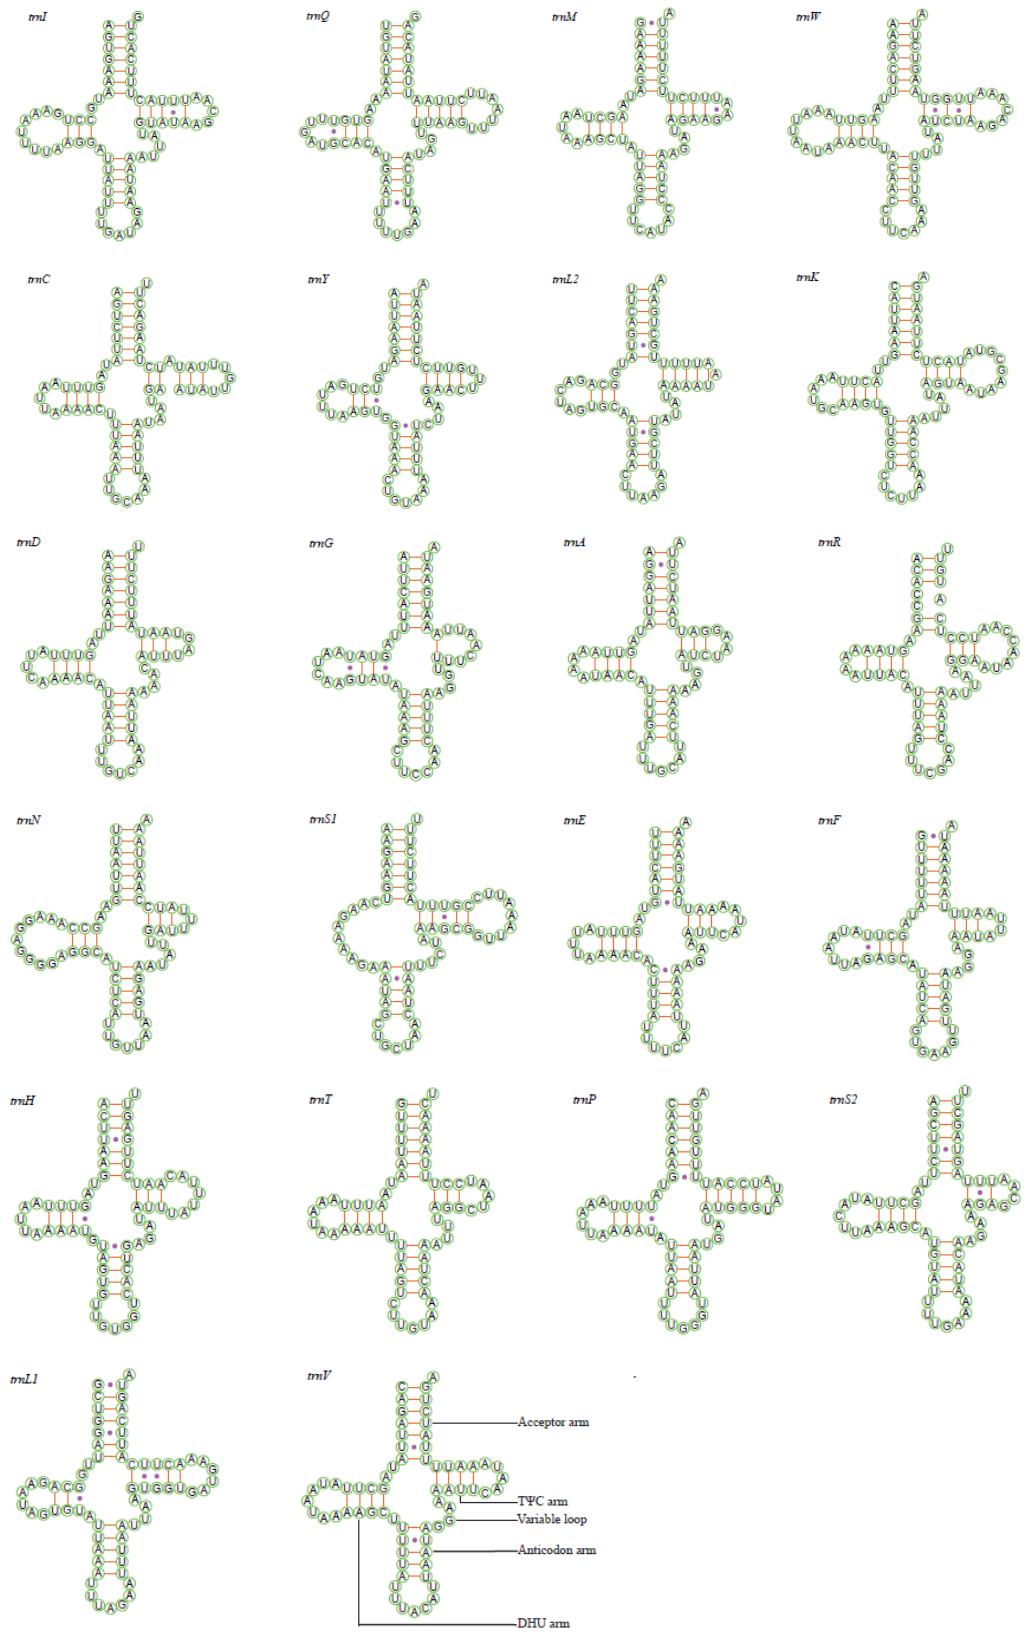
Figure 4. Predicted cloverleaf secondary structure for the 22 tRNAs of Roxasellana stellata .